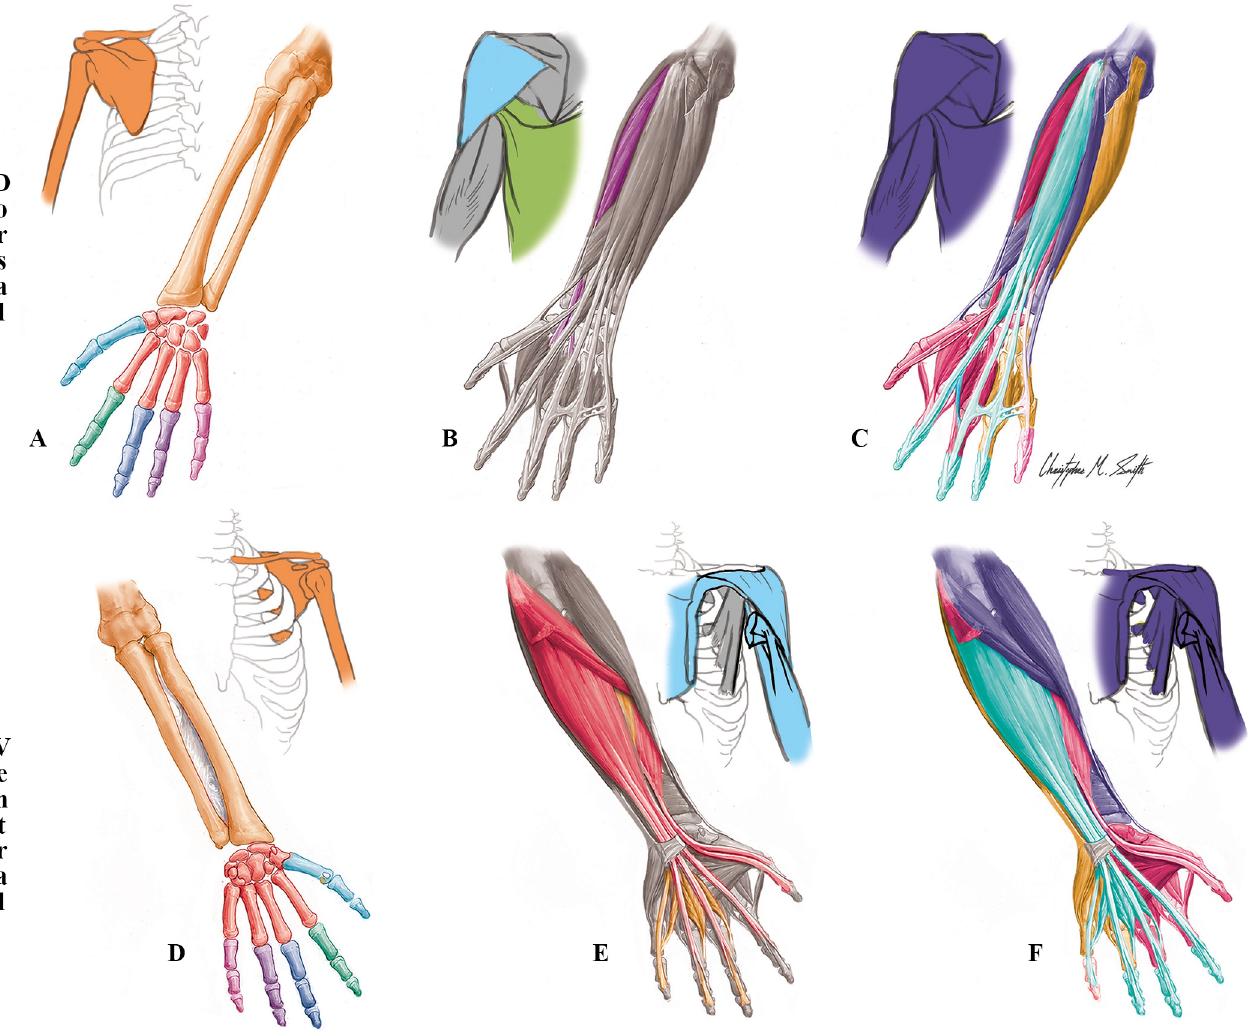
Fig 7. Modules of the T18 cyclopic fetus right UL identified using AnNA. A to C dorsal (extensor) view; D to F ventral (flexor) view. A horizontal flip was done with Photoshop, so the modules of this right UL can be more easily compared with those of the left ULs shown in Figs 1 and 4. A, D) Skeletal network modules: as in normal newborn/adult (see Fig 1). B, E) Muscle network modules: in purple , the extensor carpi radialis module; in red , the flexor module; in orange , the profundus/lumbrical module; in light green , the latissimus/teres major module; and in light blue , the biceps/coracodeltopectoral module. C, F) Musculoskeletal network modules: in purple , the scapular/forearm-thumb movement module; in aquamarine , the flexor/extensor/lumbrical module; in red , the wrist/digits 1-2-3 movement module; in light pink , the extensor digit minimi module; and in yellow , the digits 4 – 5 movement module.